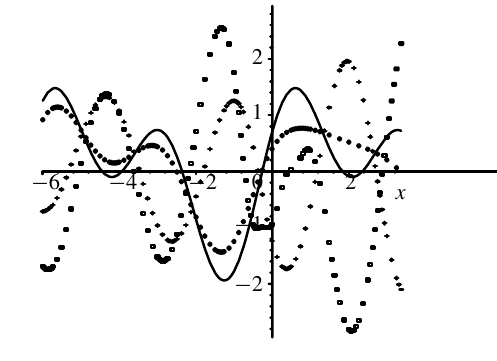
c Graph of second degree Maclaurin polynomials for the wave equation using modified Picard iteration at t = 0 ( · ) , 4 h( ◦ ) , 8 h( + ) and 11 h( ✷ ) for h = 5 /